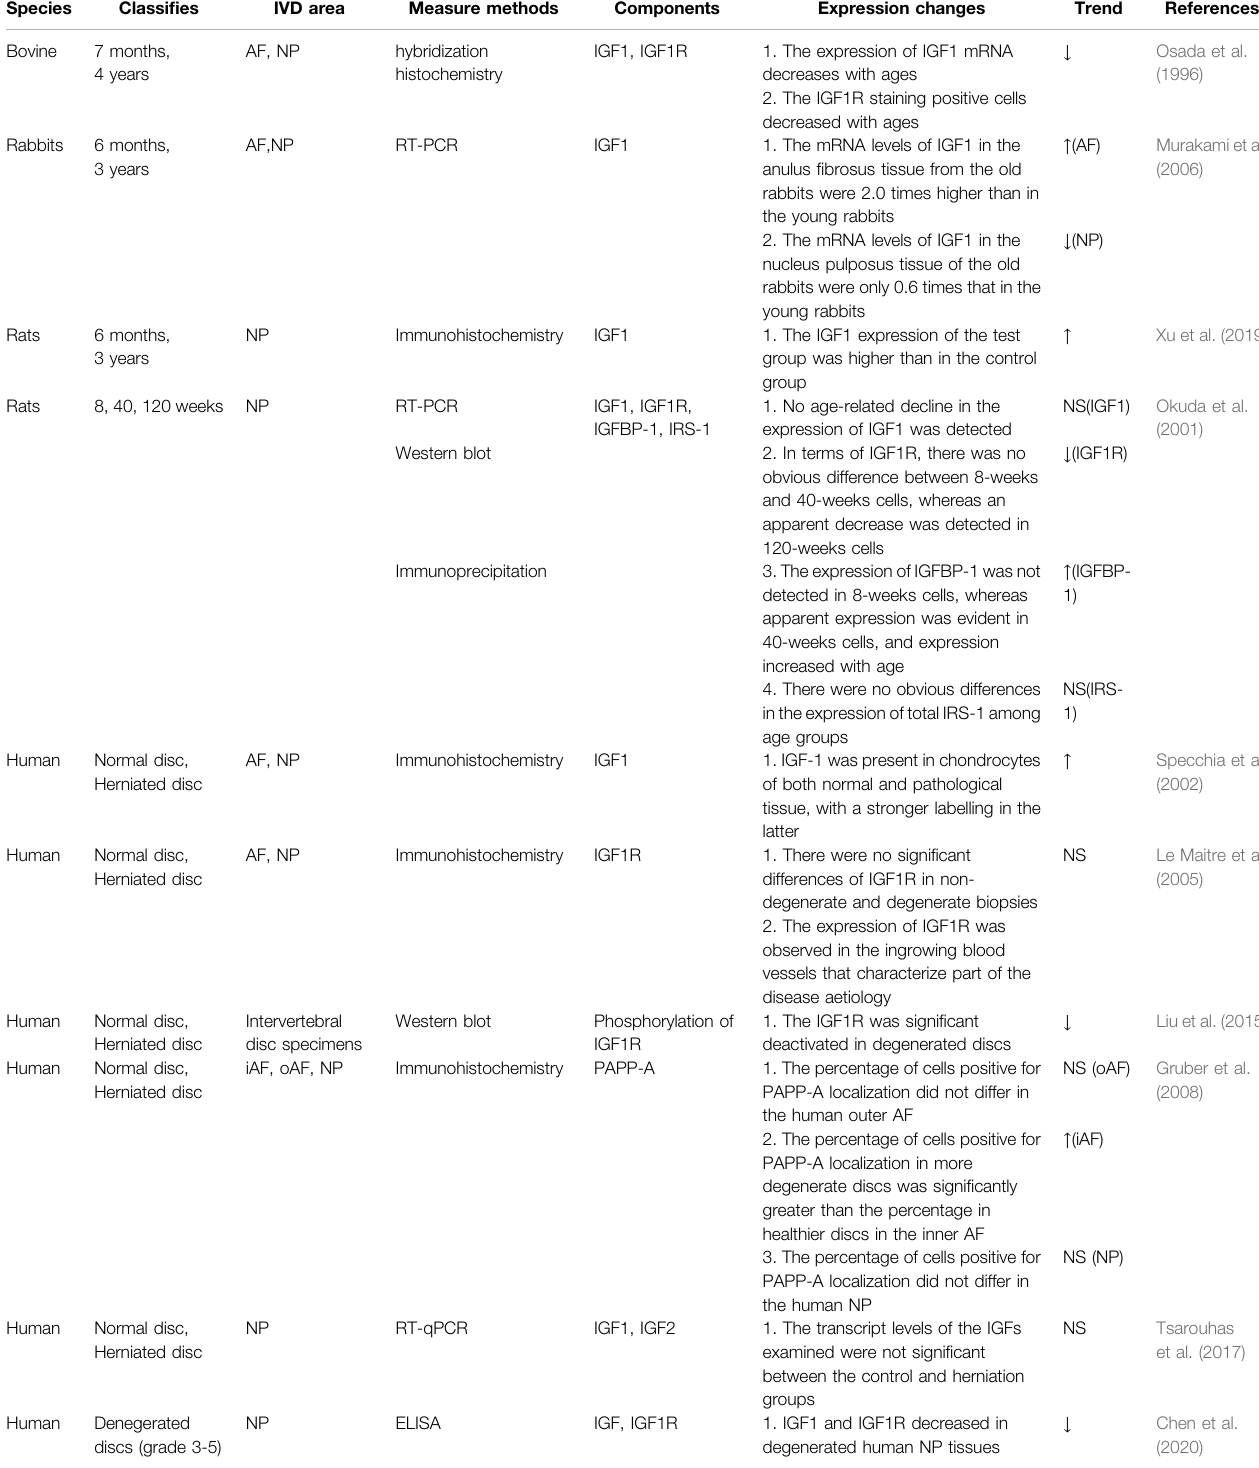
TABLE 1 | The changes in the expression of IGF signaling in the IVDs of different species (NS, not signi fi